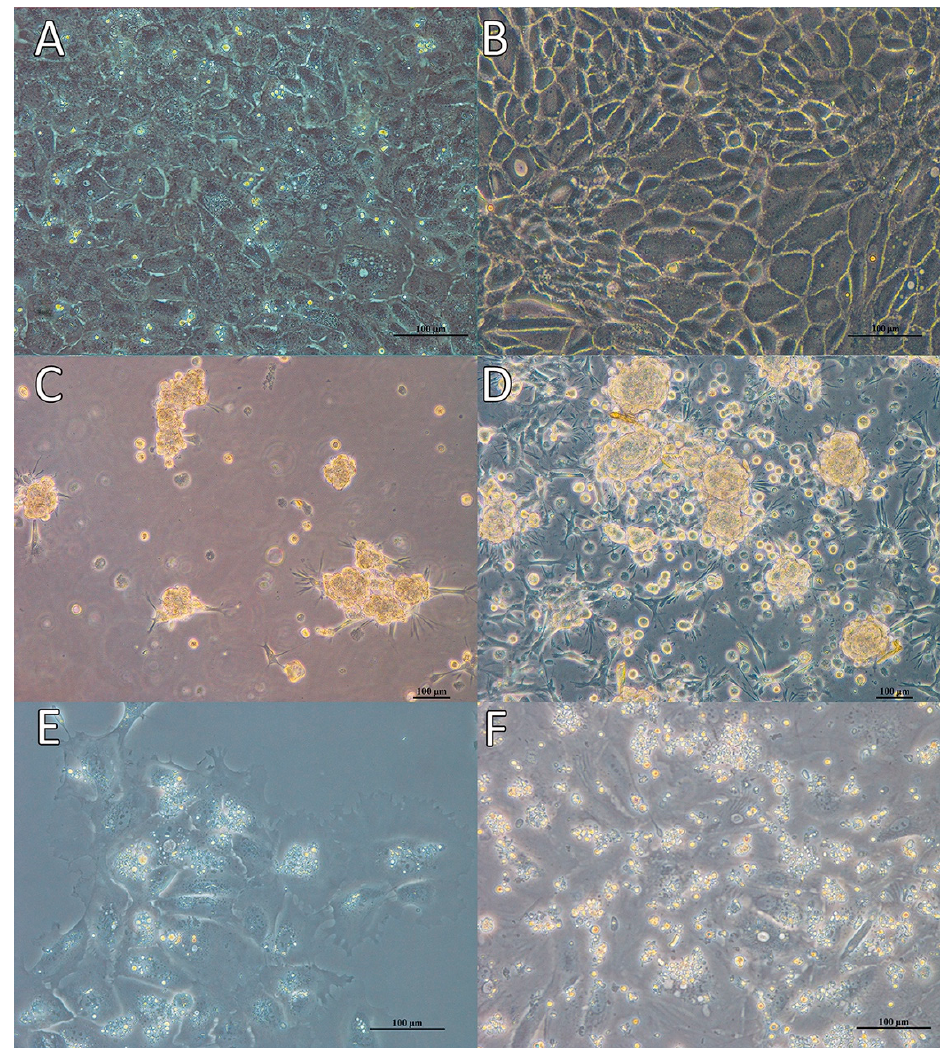
Figure 5. Morphology of Dabry’s sturgeon gonad cells ( A , B ) and purified germ cells cultured without ( C , D ) or with feeder cells ( E , F ), after 3 d ( A , C , E ) and 14 d ( B , D , F ).